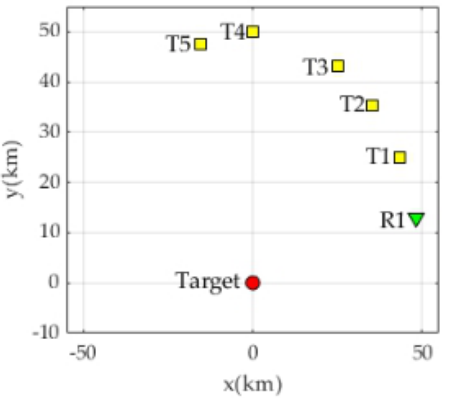
Figure 9. Radar target distribution